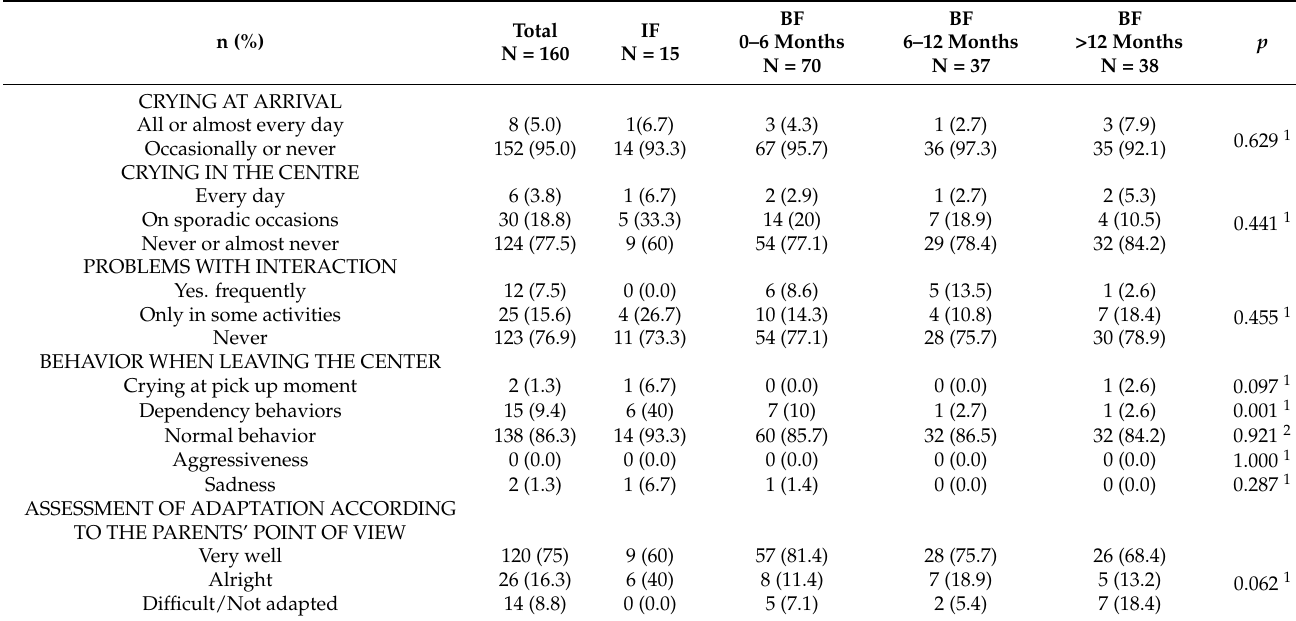
Table 2. Variables related to the child’s adaptation to schools.